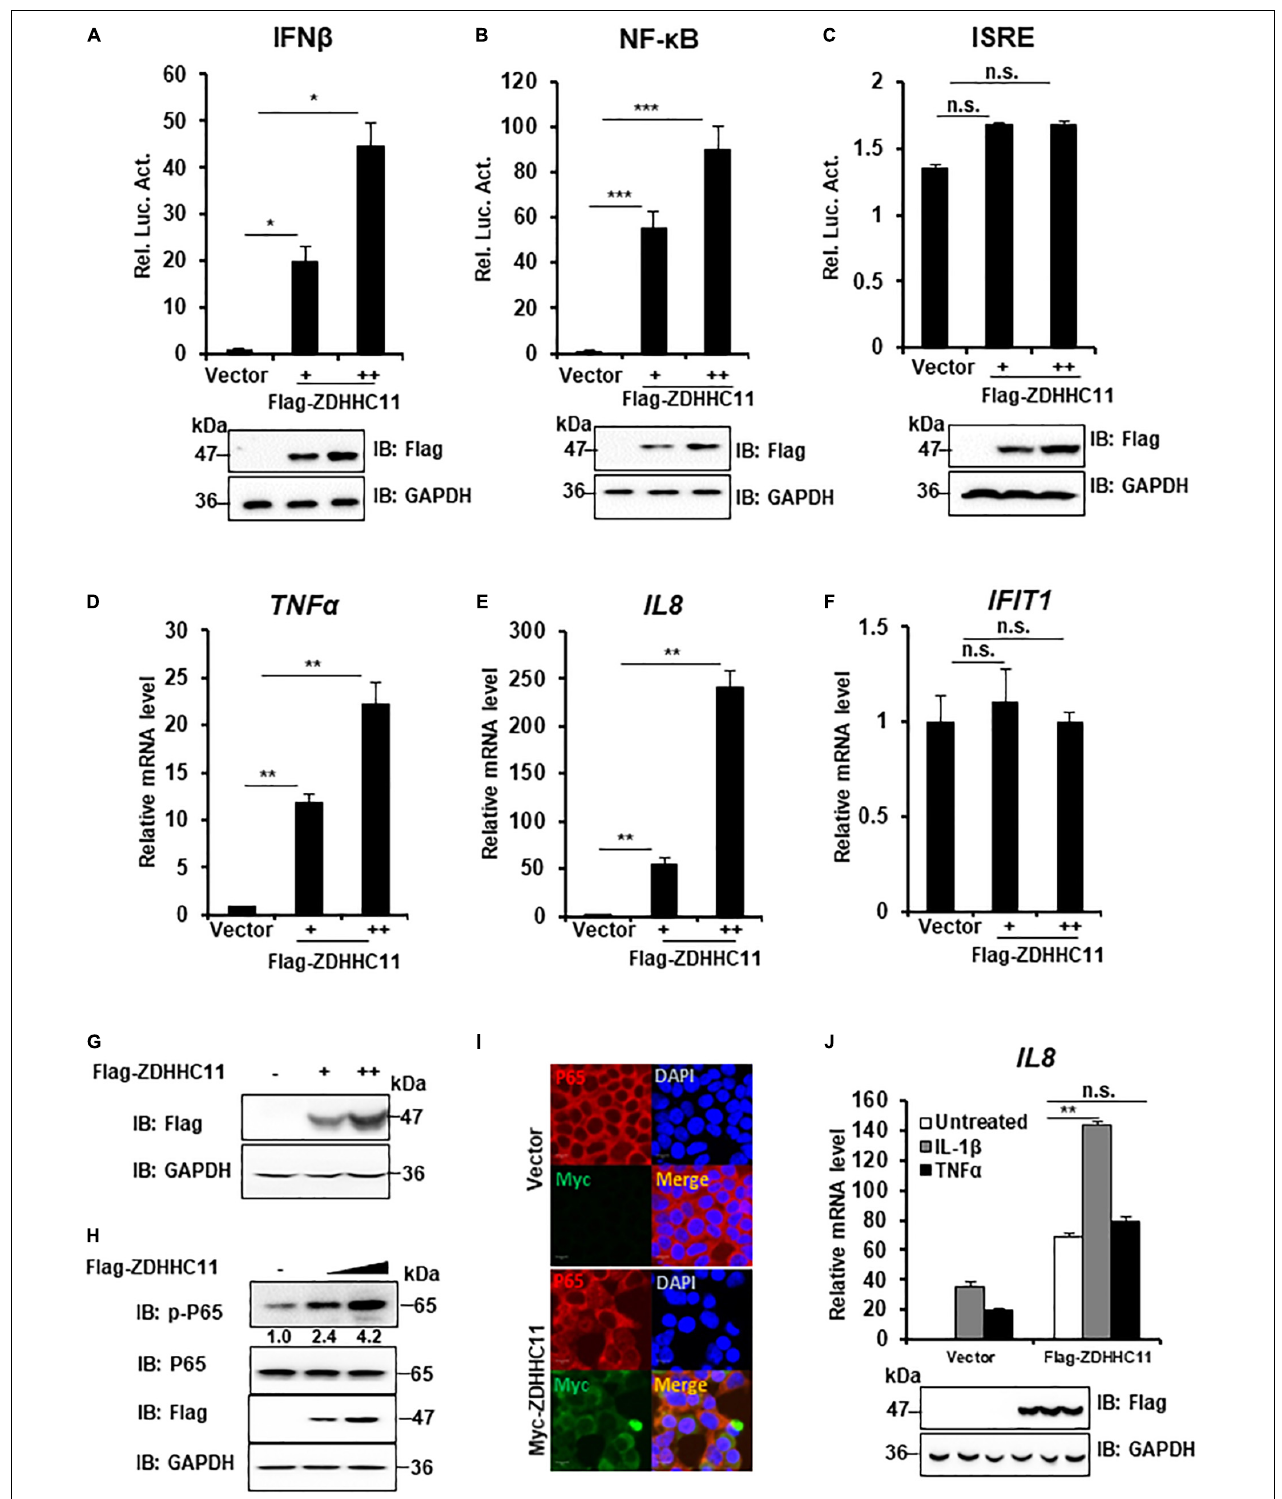
FIGURE 1 | ZDHHC11 overexpression activates NF- κ B signaling. (A–C) HEK293T cells were cotransfected with an empty vector or different doses of ZDHHC11 (50 and 100 ng) expression plasmids and luciferase reporter plasmids IFN- β -Luc (100 ng; A) , NF- κ B-Luc (20 ng; B) , or ISRE-Luc (100 ng; C) . After 24 h, the cells were harvested for luciferase reporter assay (upper panel) and immunoblot assay (lower panels). (D–G) HEK293T cells were transfected with empty vector or different